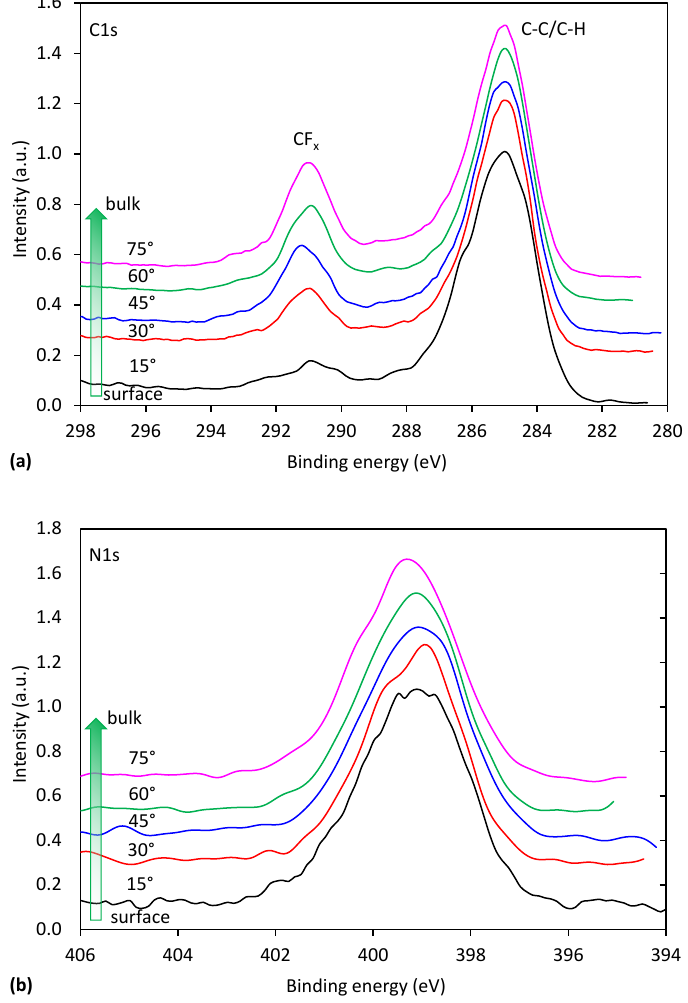
Figure 8. Evolution of high-resolution peaks of: ( a ) carbon and ( b ) nitrogen with detection